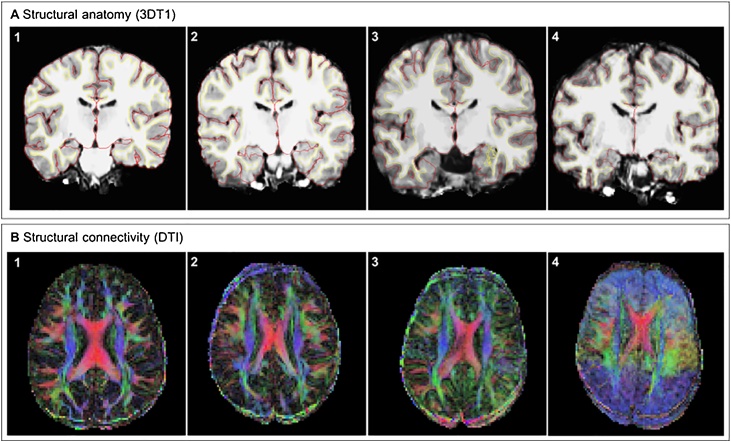
Examples of quality control classifications with scans rated as (1) Excellent, (2) Good, (3) Doubtful, and (4) Failed. A) Parcellated structural anatomy (T1 weighted) scan with pial surface (red line) and white matter/grey matter division (yellow line). B) Diffusion tensor fitted structural connectivity (DTI) scan with connections in right-left (red), anterior-posterior (green), and dorsal-ventral (blue) direction (For interpretation of the references to colour in this figure legend, the reader is referred to the web version of this article).